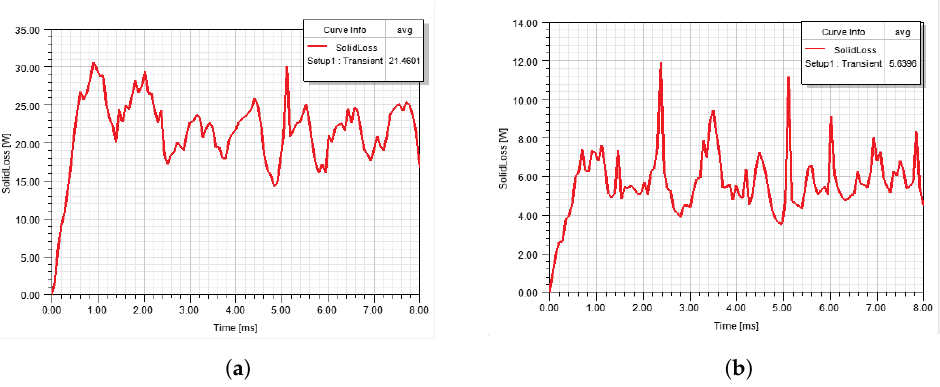
Figure 6. Eddy current losses for ( a ) nonsegmented and ( b ) two-segment magnets. The eddy current losses P e can also be calculated analytically using Equation